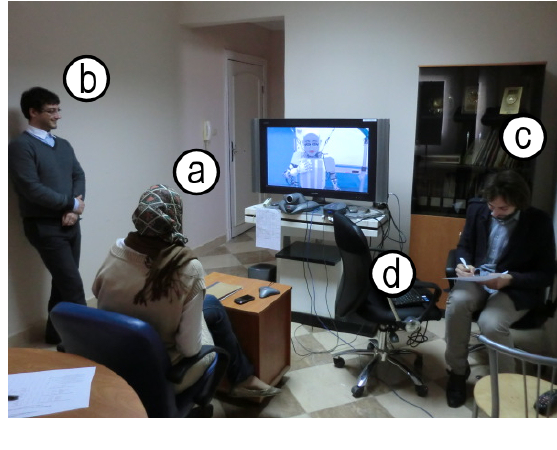
Figure 3. Experimental setup, with the subject (a) watching the screen, and the two examiners (b and c) focusing on the subject and controlling a computer